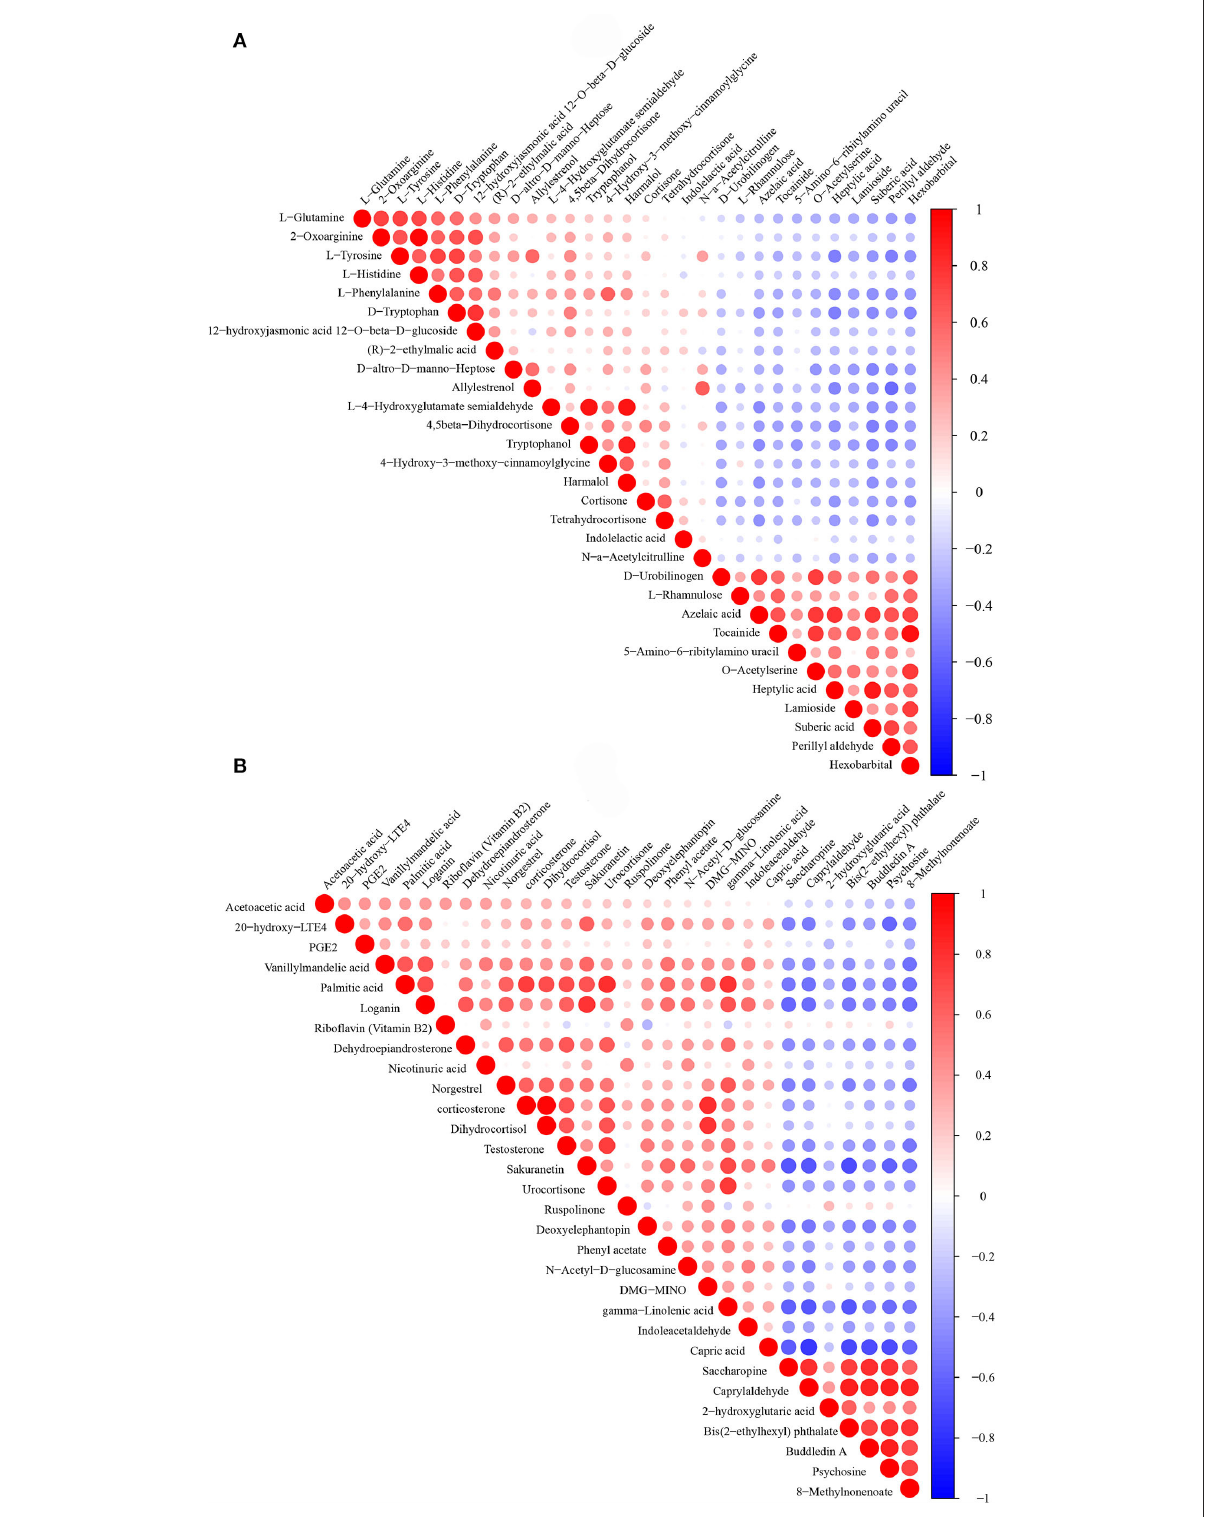
FIGURE5 (A) is the Pearson correlation coefficient of the environmental factor group (DUvsG), and DUvsG refers to the group “Deep-underground vs. ground”; (B) is the Pearson correlation coefficient of the sleep quality group (GSQvsPSQ), and GSQvsPSQ refers to the group “Good sleep quality vs. poor sleep quality.” Red indicats a positive correlation, and blue indicats a negative correlation. The size of the dot represents the size of the correlation